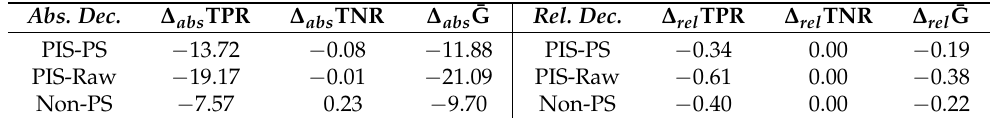
Table 2. Performance decline, comparing validation data with test data. ( Left ): Absolute decrease ( ∆ abs X : = X test − X valid ). ( Right ): Relative decrease ( ∆ rel X : = ∆ abs X/X valid